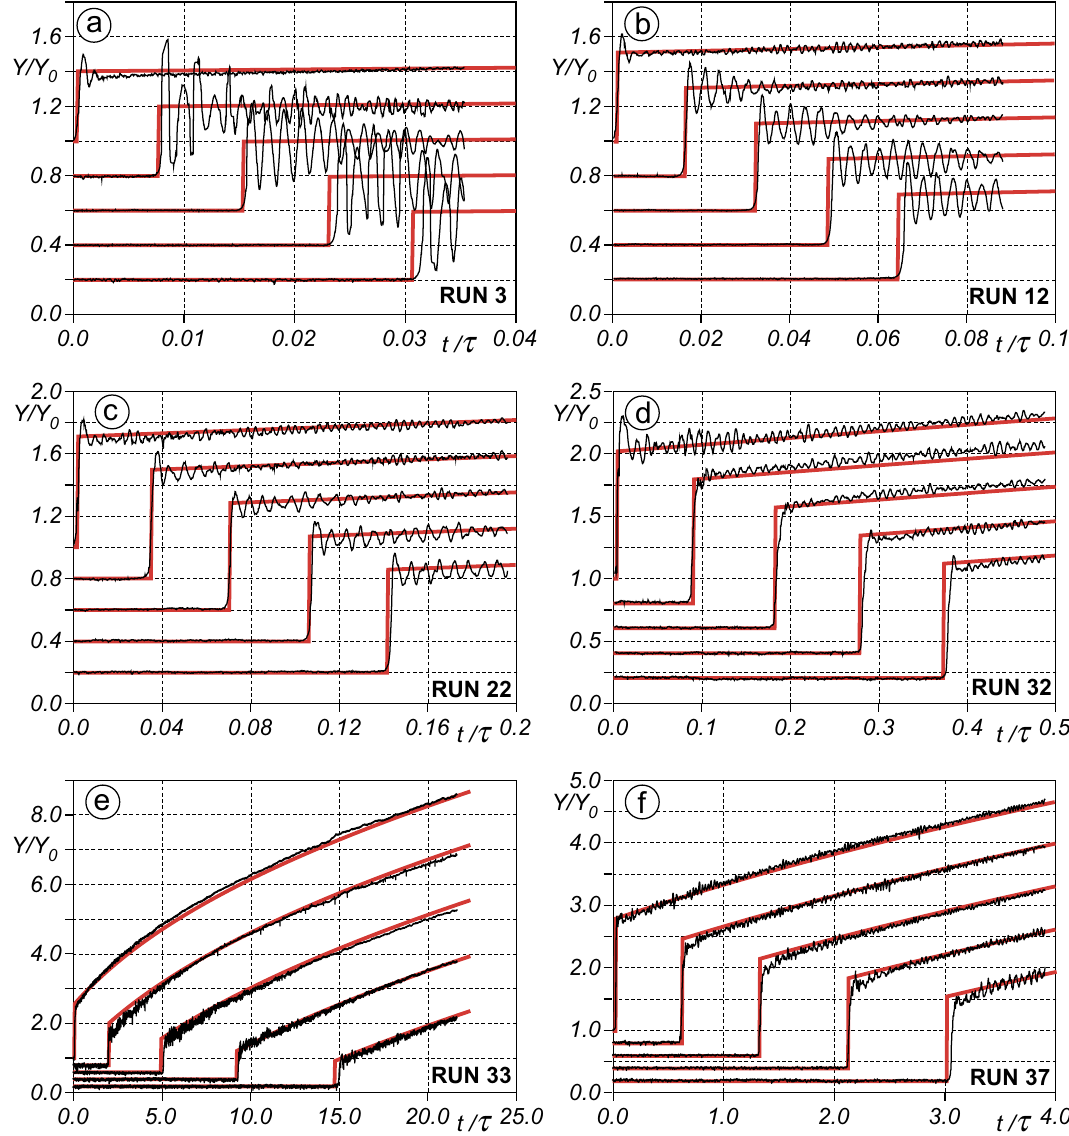
Figure 5. Dimensionless time variation of the flow depth during the surge propagation: red and black lines denote the 0D model and experimental results, respectively; each curve is offset vertically by 0.2. ( a ) run 3 ( s = 0.0002, Y 0 = 0.084 m, U 0 = 0.34 m/s, F 0 = 0.37); ( b ) run 12 ( s = 0.0005, Y 0 = 0.102 m, U 0 = 0.47 m/s, F 0 = 0.47); ( c ) run 22 ( s = 0.010, Y 0 = 0.058 m, U 0 = 0.46 m/s, F 0 = 0.61); ( d ) run 32 ( s = 0.0022, Y 0 = 0.085 m, U 0 = 0.81 m/s, F 0 = 0.89); ( e ) run 33 ( s = 0.0052, Y 0 = 0.011 m, U 0 = 0.43 m/s, F 0 = 1.31); ( f ) run 37 ( s = 0.0052, Y 0 = 0.032 m, U 0 = 0.81 m/s, F 0 =